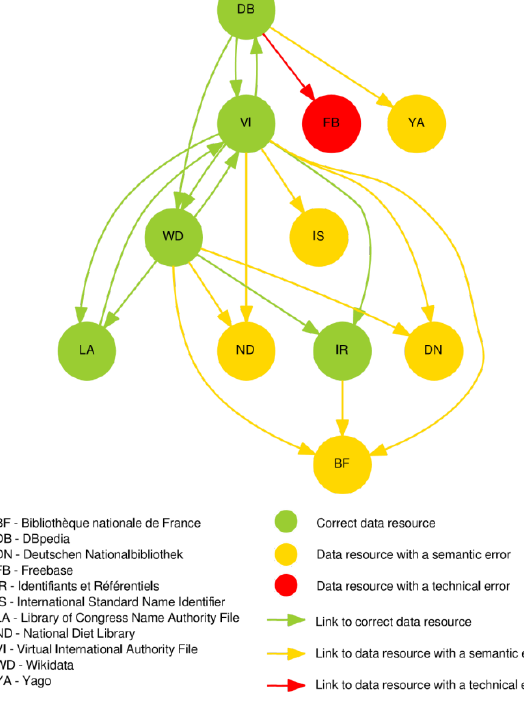
Figure 2. Data Network of the term “M. F. Goodchild”.